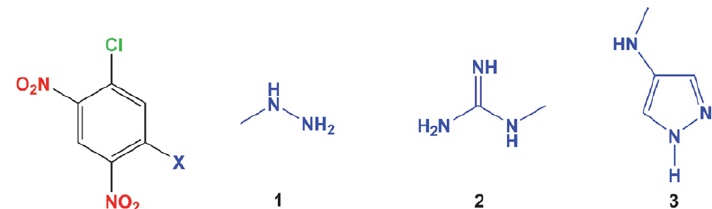
Figure 1. The structural formulas of the nitrogen-rich energetic